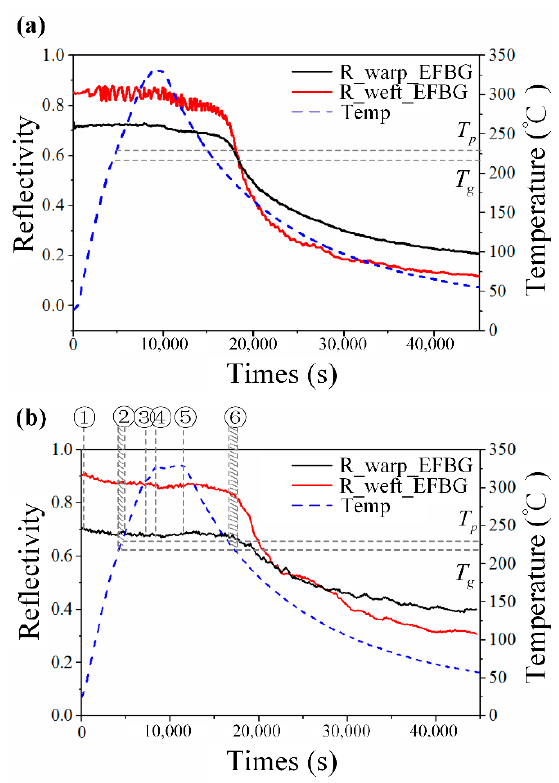
Figure 12. Reflectivity change during the forming process of ( a ) the experiment corresponding to Figure 10 and ( b ) the second set of experiments.